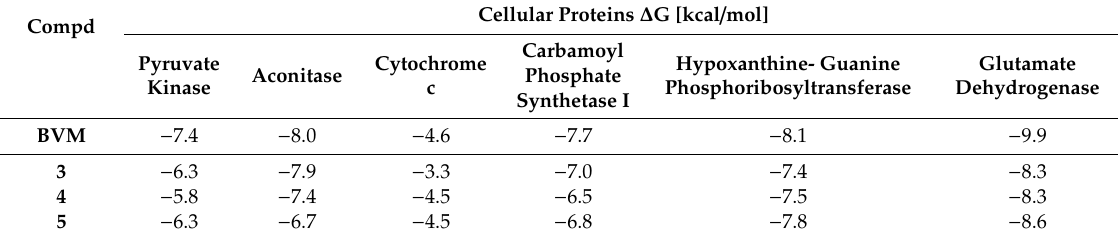
Table 4. Scoring functions of the tested compounds and cellular